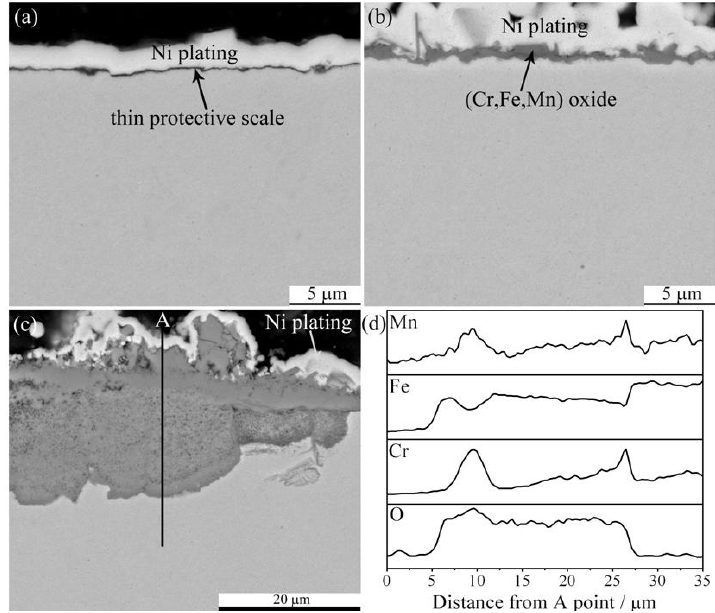
Figure 4. Cross section morphologies of base oxide scales formed on P92 after 24 h oxidation in pure oxygen at ( a ) 600 °C; and ( b ) 800 °C; ( c ) Cross section image of oxide nodules formed at 800 °C; and ( d ) chemical composition distribution along the line indicated in ( c